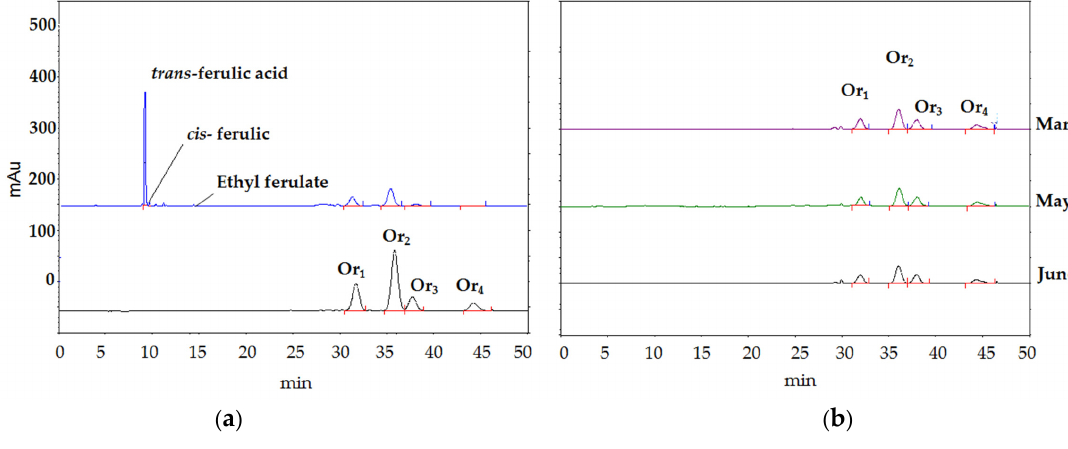
Figure 2. The High performance liquid chromatography (HPLC) chromatograms of ( a ) authentic γ -oryzanol before (lower line) and after hydrolysis (upper line); and ( b ) the Ory-extracts from the rice bran oil (RBO) soapstock samples obtained in March, May, and June of 2016.